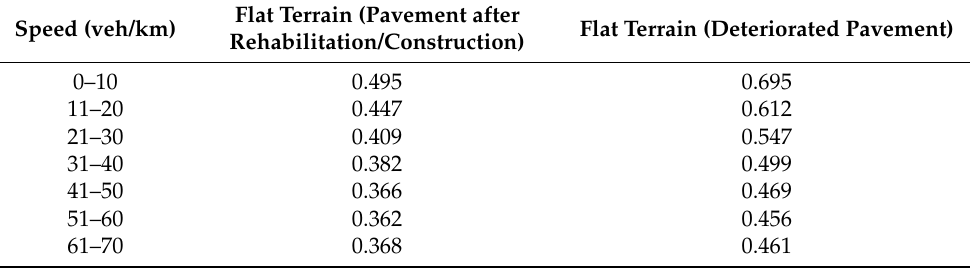
Table A5. Unit costs of truck air pollution (EUR/veh km), prices 2019. Flat Terrain (Pavement after Speed (veh/km)